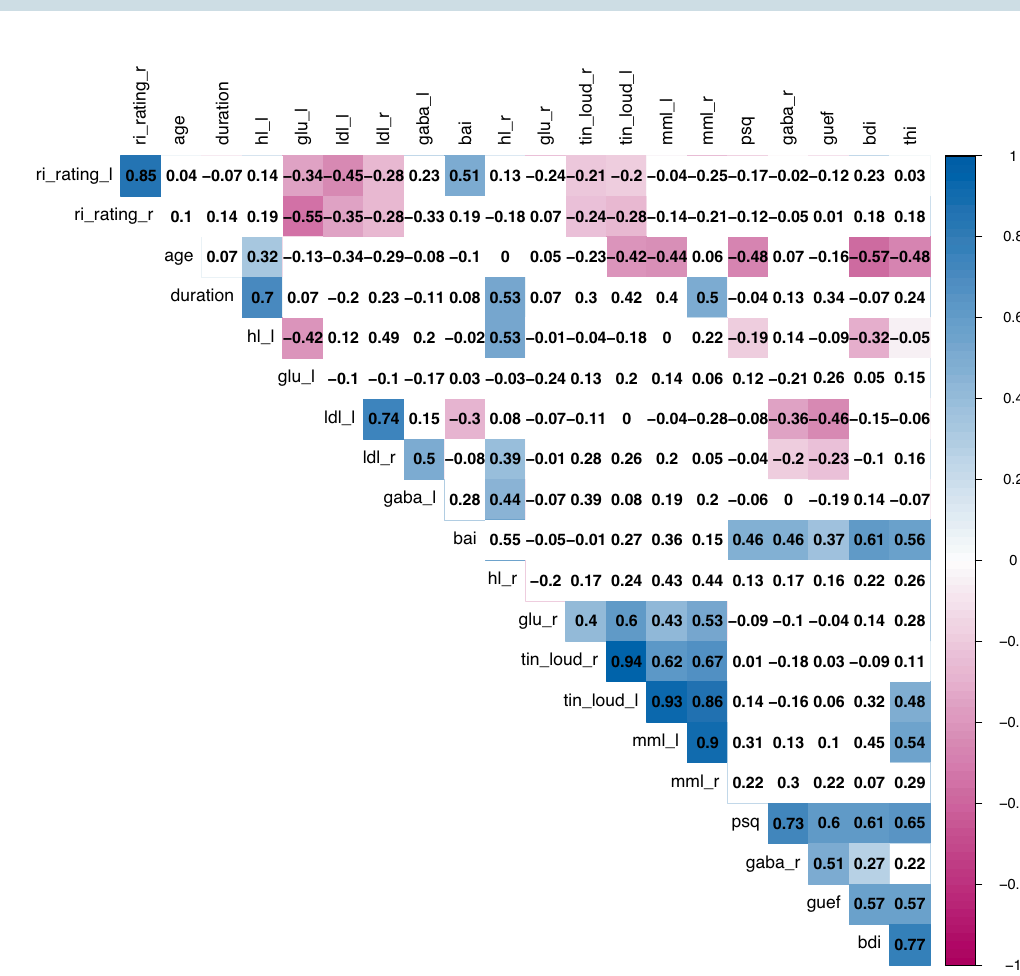
Figure 5. Correlation matrix of variables of interest and GABA/Glu concentration levels in the tinnitus group ( n = 16). Spearman correlations were used. Colored tiles indicate significant correlations ( p < 0.05) and correlation strengths are coded in color saturation (positive = blue, negative = red). Correlation coefficients are automatically sorted with the built-in hierarchical clustering function of the corrplot package for better navigation of results ( psq Perceived Stress Questionnaire 34,35 , gaba _ r GABA concentration in the right hemisphere ROI, bai Beck Anxiety Inventory 37 , guef Geräuscheüberempfindlichkeits-Fragebogen 41 , bdi Beck Depression Inventory 36 , thi Tinnitus Handicap Inventory 39,40 , ri _ rating _ l residual inhibition left ear, ri _ rating _ r residual inhibition right ear, hl _ l mean hearing loss left ear, hl _ r mean hearing loss right ear, tin _ loud _ r tinnitus loudness right ear, tin _ l oud _ l tinnitus loudness left ear, mml _ l minimal masking level left ear, mml _ r minimal masking level right ear, gaba _ l GABA concentration in the left hemisphere ROI, ldl _ l loudness discomfort level left ear, ldl _ r loudness discomfort level right